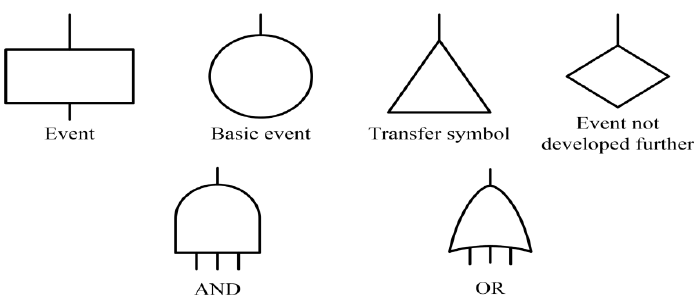
Figure 1. Common event representations and logic operations of fault